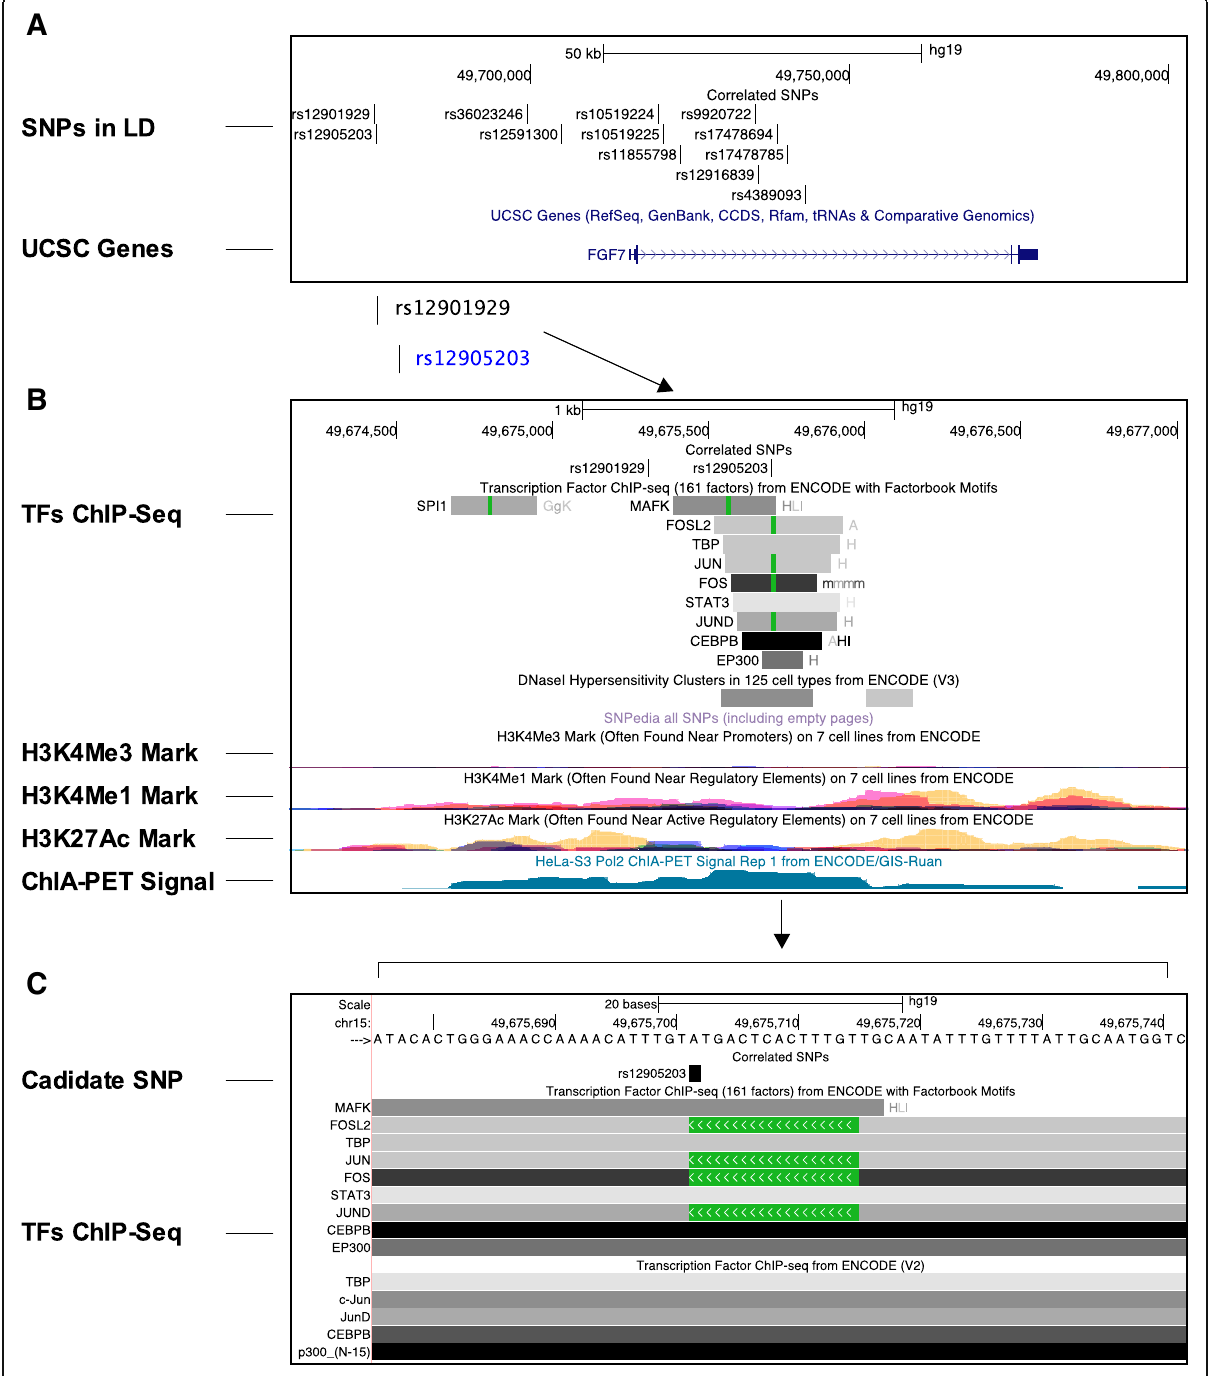
Fig. 1 The candidate functional variant resides in a putative enhancer element. a the relative locations of the 12 SNPs that correlated with the tag-SNPs rs12591300 (or rs10519225) with an r 2 greater than 0.8. Four SNPs lie upstream of the promoter of the FGF7 gene, and eight SNPs are in the intron of the FGF7 gene. b The variant rs12905203 resides in a putative enhancer element that binds multiple transcription factors, including AP-1 and histone modification enzymes, and overlaps with H3K4me1 and H3K27ac marks. c Zoomed in view of the variant and surrounding DNA sequence revealed that the altered allele of the variant might affect binding of AP-1 transcription